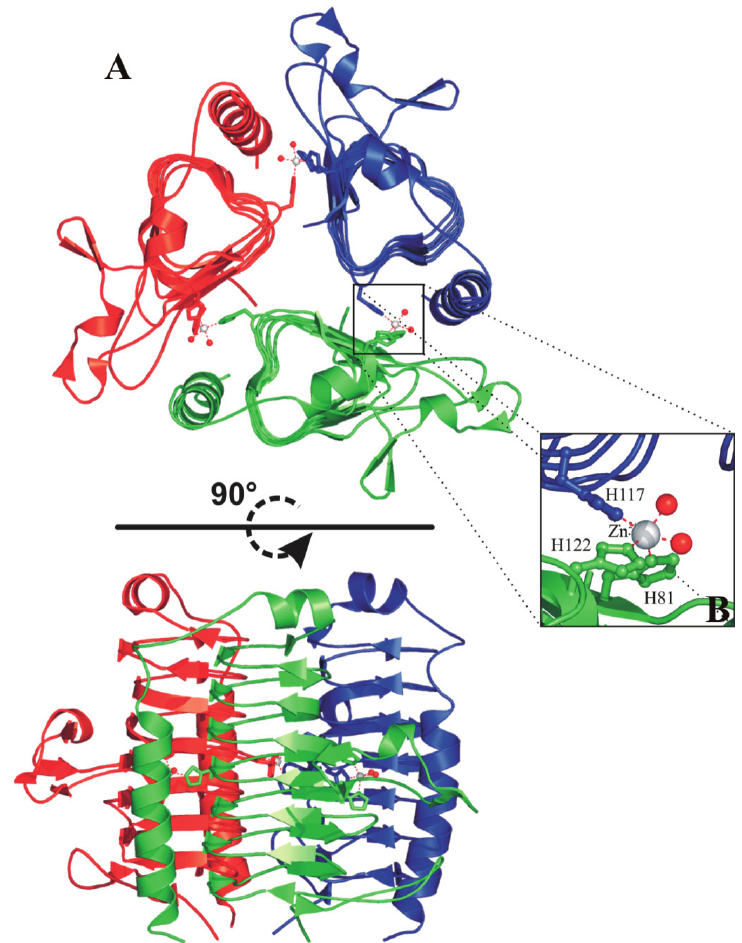
Figure 9. ( A ) Two different views of the MtCam trimer (PDB code 1QRG). The three monomers are reported in green, red and blue. Zinc ions are shown as spheres and their coordinating residues are shown in ball-and-stick representation. Secondary structure assignments were obtained from PROMOTIF [93]; ( B ) enlarged view of the active site of